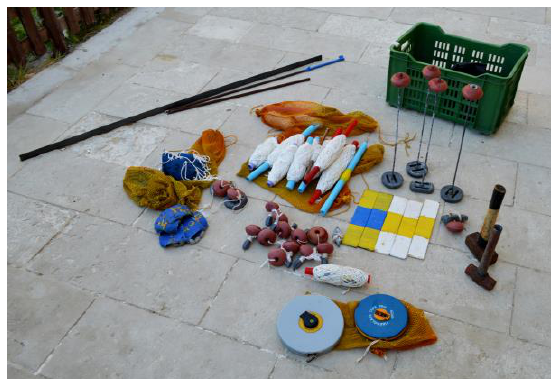
Figure 2. Materials used in data acquisition (photo by Mohamed Elsayed)